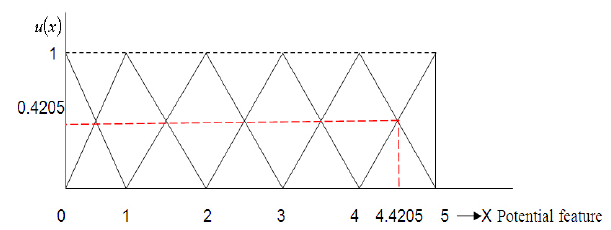
Figure 5: The membership function figure of five-level semantic variables Table 6: The descriptive statistics of the third part of the fuzzy semantic questionnaire